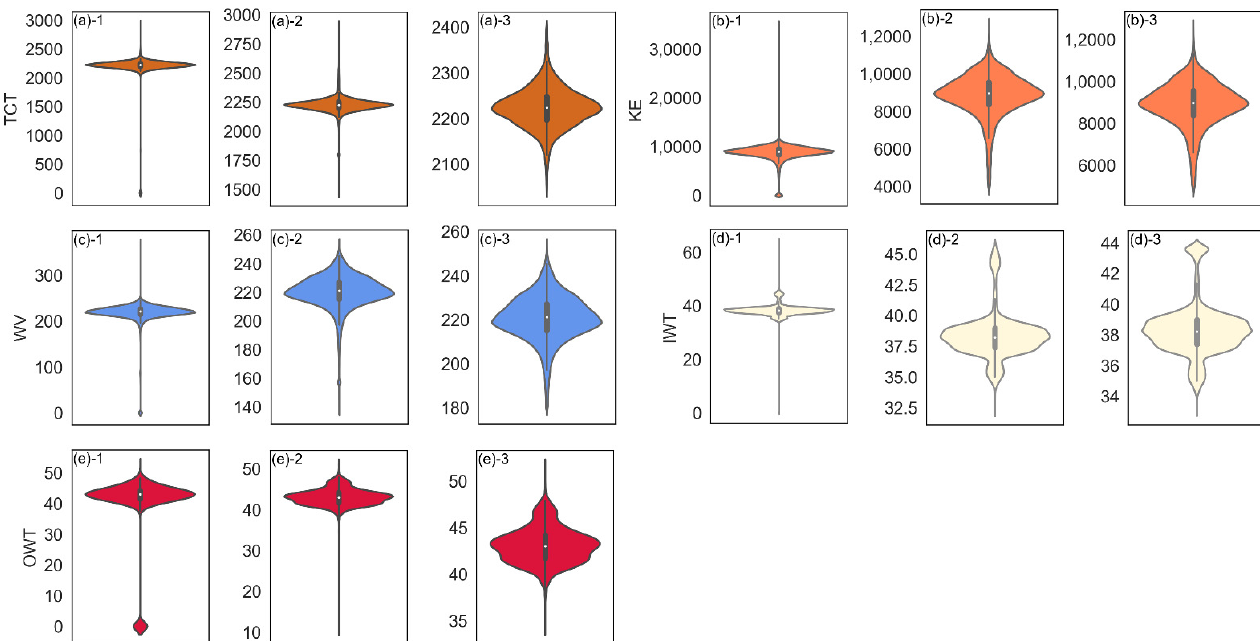
Figure 4. ( a – e ) Comparison of original data and processed data (4), i (i = 1, 2, 3,) represents the data before a feature is processed, after it is processed by the box plot, and after it is processed by the 3 σ criterion, respectively.